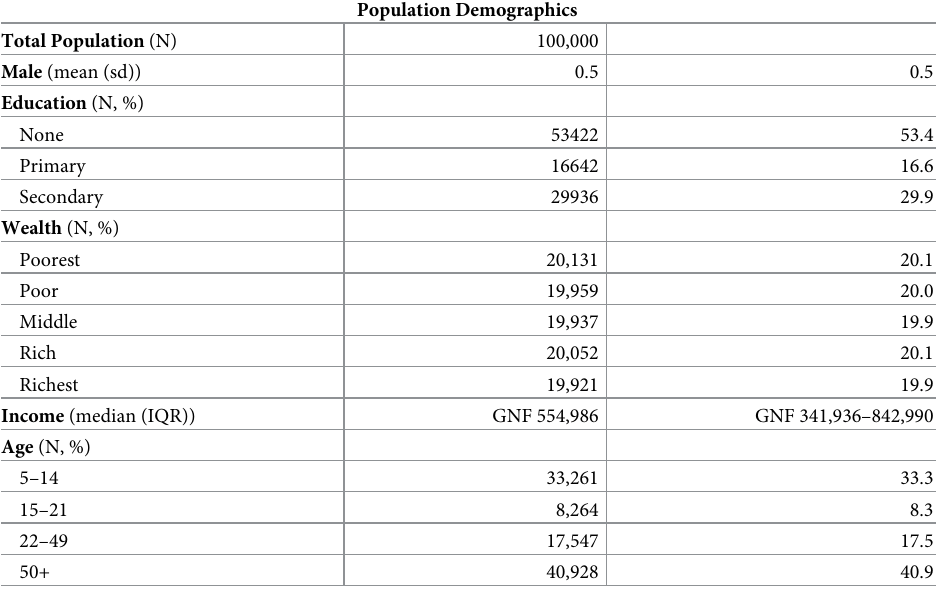
Table 1. Demographic characteristics of the model